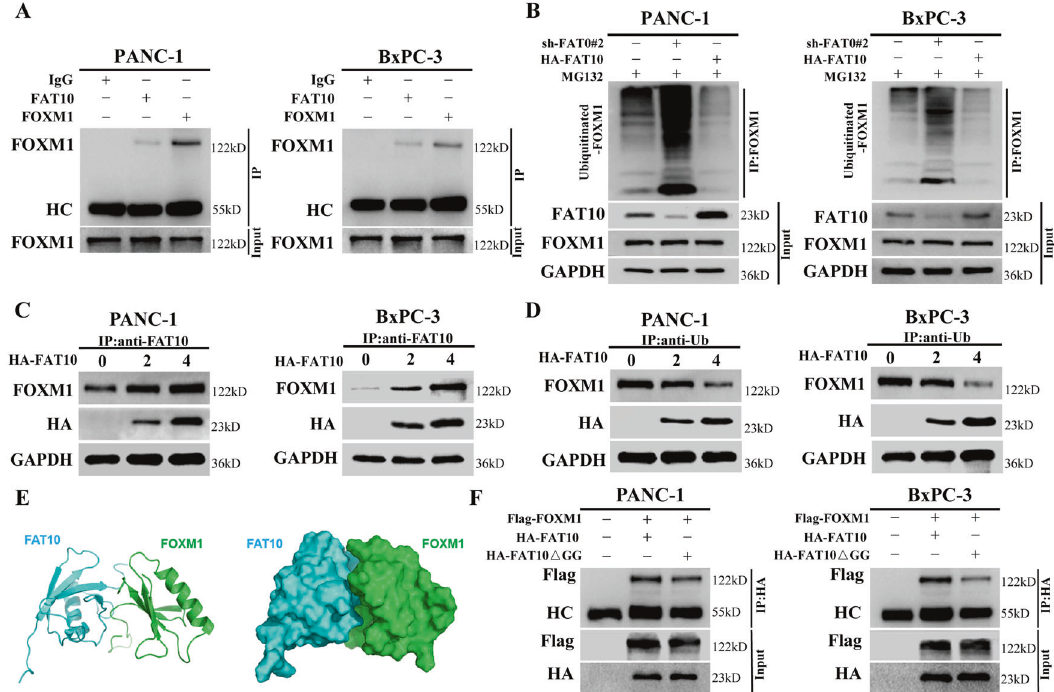
Fig. 7 FAT10 competes with ubiquitin to bind and stabilize FOXM1. A Co-IP was used to detect the interaction between FOXM1 and FAT10 in PANC-1 and BxPC-3 cells. HC, heavy chain. B MG132 (10 μ M) was added to PANC-1 and BxPC-3 cells, shFAT10 or HA-FAT10 plasmid was transfected at the same time, and then co-IP was used to detect the levels of ubiquitin bound to FOXM1 protein. C PANC-1 and BxPC-3 cells were transfected with different amounts of HA-FAT10 plasmid, and the level of FAT10 binding to FOXM1 protein was detected by co-IP. D PANC-1 and BxPC-3 cells were transfected with different amounts of HA-FAT10 plasmid, and the level of Ub binding to FOXM1 protein was detected by co-IP. E Docking conformation of the fi rst ranking score. Three-dimensional structure of FAT10 and FOXM1. FAT10 is shown in green. FOXM1 is shown in cyan. F The Flag-FOXM1 plasmid was transfected into PANC-1 and BxPC-3 cells, the HA-FAT10 or HA-FAT10 Δ GG plasmid was transfected at the same time, and then the protein level of Flag-FOXM1 bound to the HA-tagged protein was detected by co-IP. HC, heavy